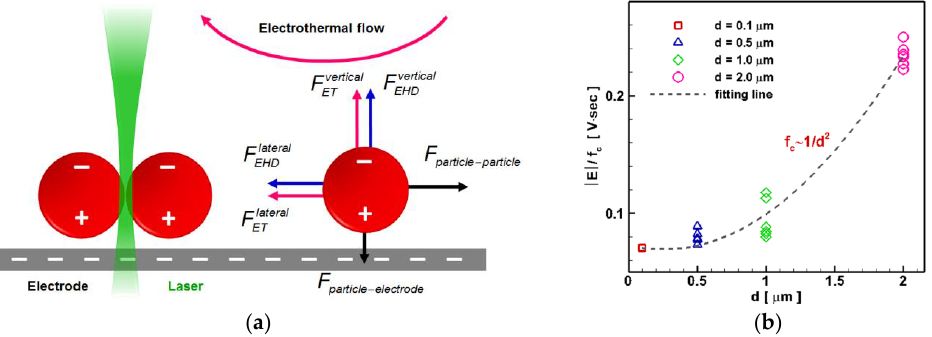
Figure 10. Physics of the REP technique. ( a ) Various forces involved in REP process. ( b ) Dependence of REP critical frequency on particle size. Reproduced from [58], with the permission of American Chemical Society (2010).